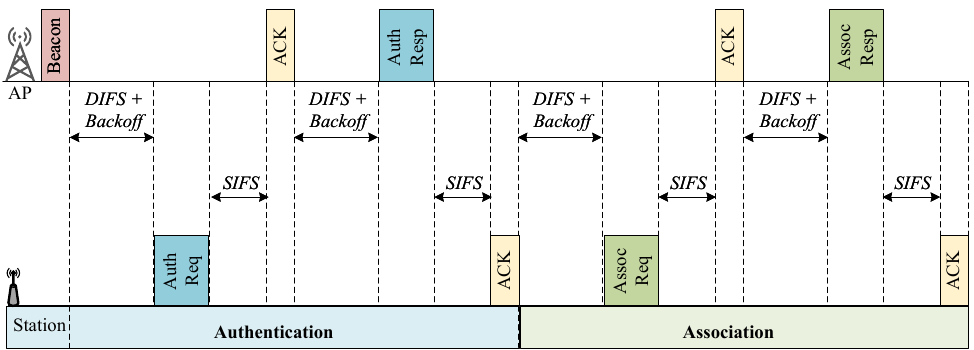
Figure 5. The station link setup process with access point in IEEE 802.11ah